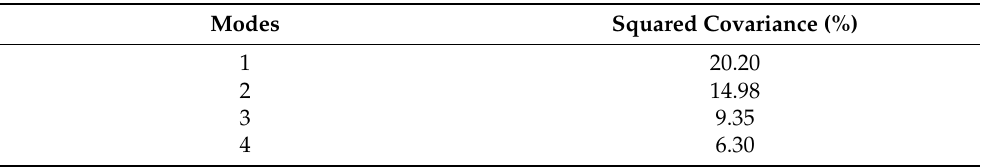
Figure 11. Time components of the second SVD of the residuals of the variable pair (monthly values) SP (magenta line) and Up coordinate (green line). Table 5. Percentage of squared covariance explained by the first four modes of variability of the residuals of the pair Up–TWS.